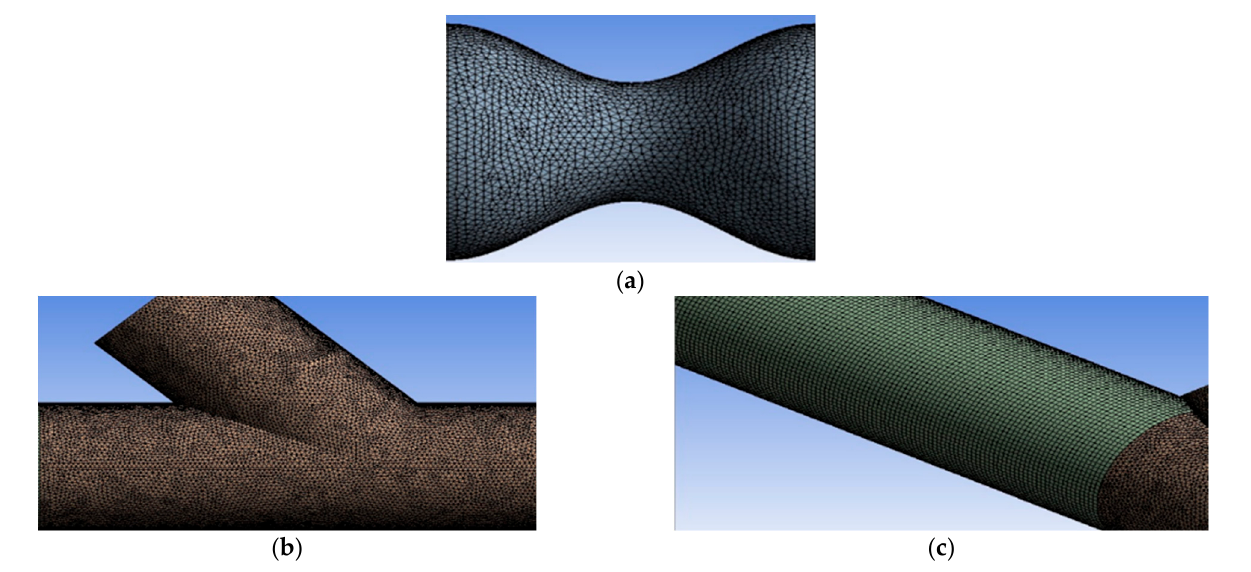
Figure 4. ( a ) and ( b ) grid sections with tetrahedral elements, ( c ) grid segment with hexahedral ele- ments.